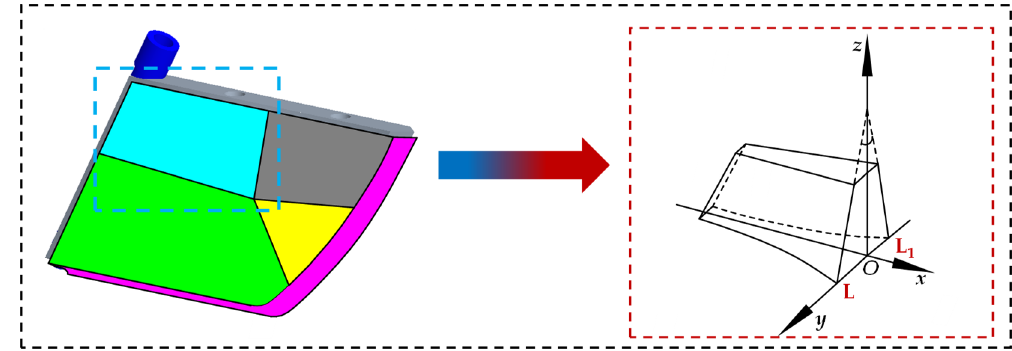
Figure 12. Schematic diagram of guide inclined surface structure.